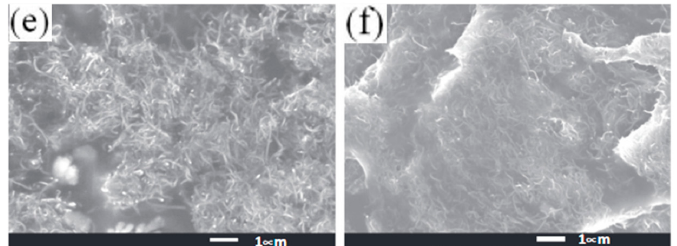
Figure 11. ( a ) Pristine CNF (multi-walled carbon nanotubes) and ( b ) PIL-PMMA-IL composite and